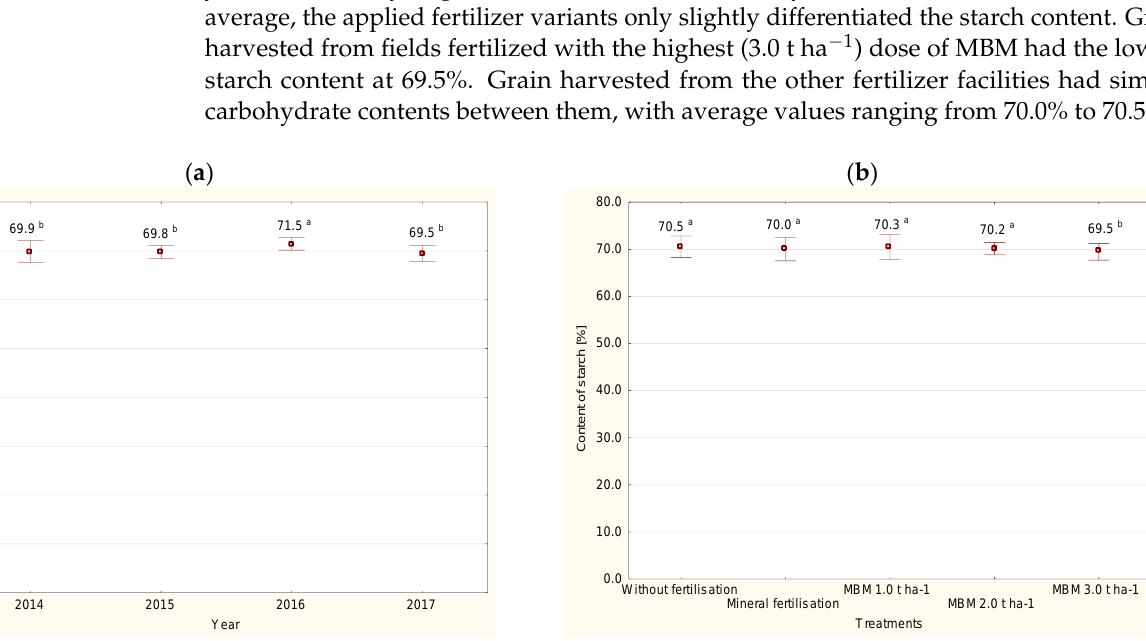
Figure 4. Starch content in corn grains (mean value and standard deviation), ( a ) average for the years, (b) average for the treatment. MBM — Meat and Bone Meal. a,b — Values followed by the same letters do not differ significantly in Tukey’s (HSD) test ( p < 0.05). Table 7. Starch content in corn grains (mean value and standard deviation), interaction between the years and treatments, %.